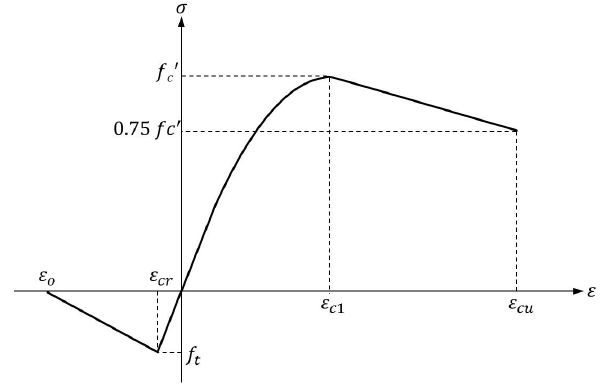
Figure 1. Stress-strain relation of